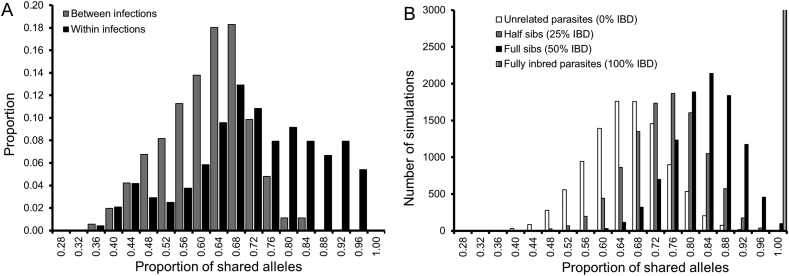
Relatedness of parasite haplotypes within asymptomatic infections. Panel A shows the observed frequency distribution of pairwise allele-sharing (ps) between parasite haplotypes recovered from the same or different infections. Grey bars denote comparisons between infections while black bars show within-infection comparisons. Panel B shows simulated allele-sharing (ps) distributions expected of parasites in the different classes of relatedness. We simulated ps expected of haploid parasites derived from the same inbred oocyst (100% identity-by-descent; IBD), from the same outcrossed oocysts (50% IBD), from two related oocysts (25% IBD) and from two unrelated oocysts (0% IBD). Upper and lower confidence limits for these ps distributions are shown in Table 1 and define thresholds for categorizing parasite haplotypes into different classes of relatedness.